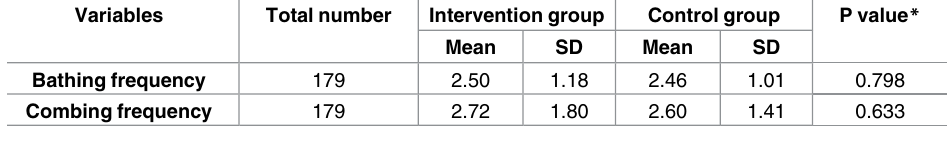
Table 2. Frequency distribution of the students’ bathing and combing information in the intervention and control groups.